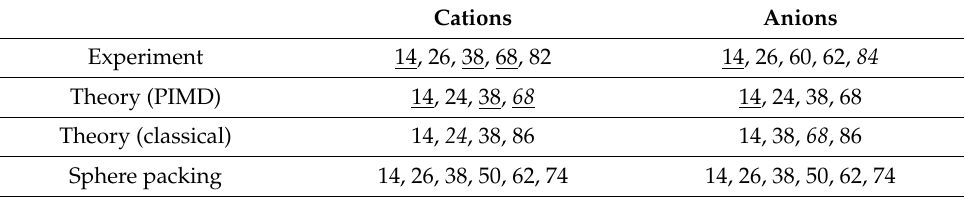
Table 1. The magic numbers observed and calculated for He n Hbc ± , n ≥ 14. Minor magic numbers are in italics. The last row lists the shell closures that are expected if the adsorbate layer grows by successively filling rings containing 6 + 6 He atoms each, and the central benzene ring is occupied. Underlined numbers indicate an agreement between the experiment and quantum